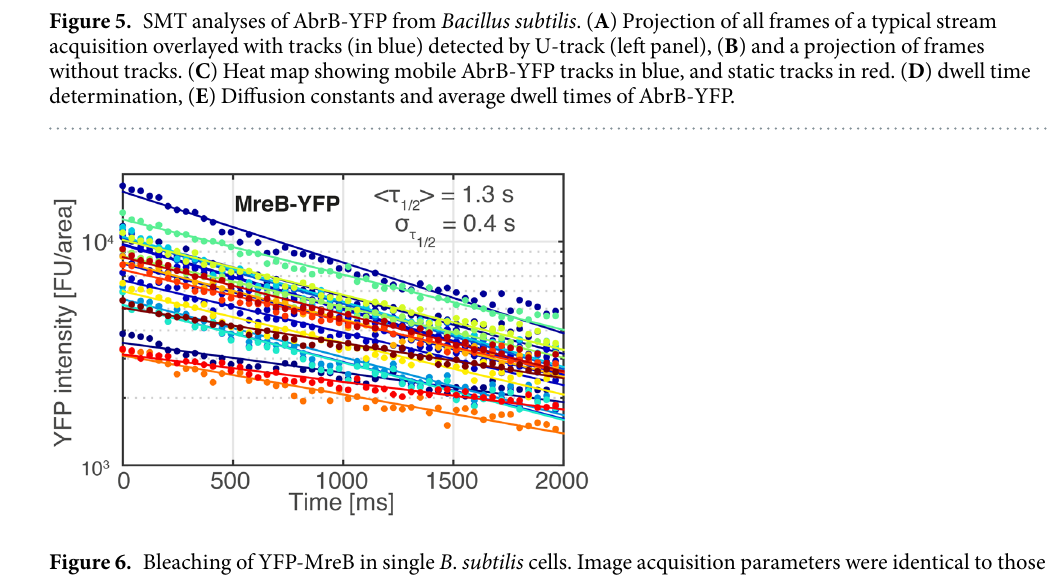
highlighting the usefulness of combining multiple approaches of SMT data analysis in the SMTracker suite. Using this pipeline, we show that the genome-wide repressor AbrB in B . subtilis shows three fractions of different mobil- ity, with one third of the molecules being bound to DNA throughout the genome, about one third sliding along